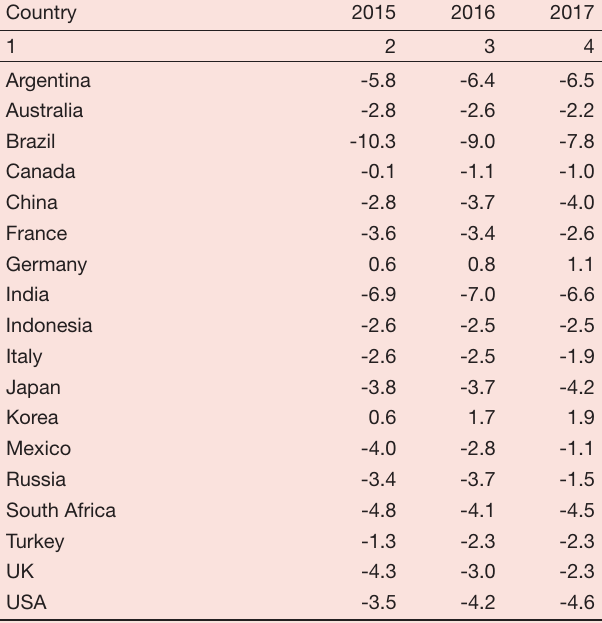
Table II.5.2: General Government Balance of Select G-20